Question: What type of chart is this?
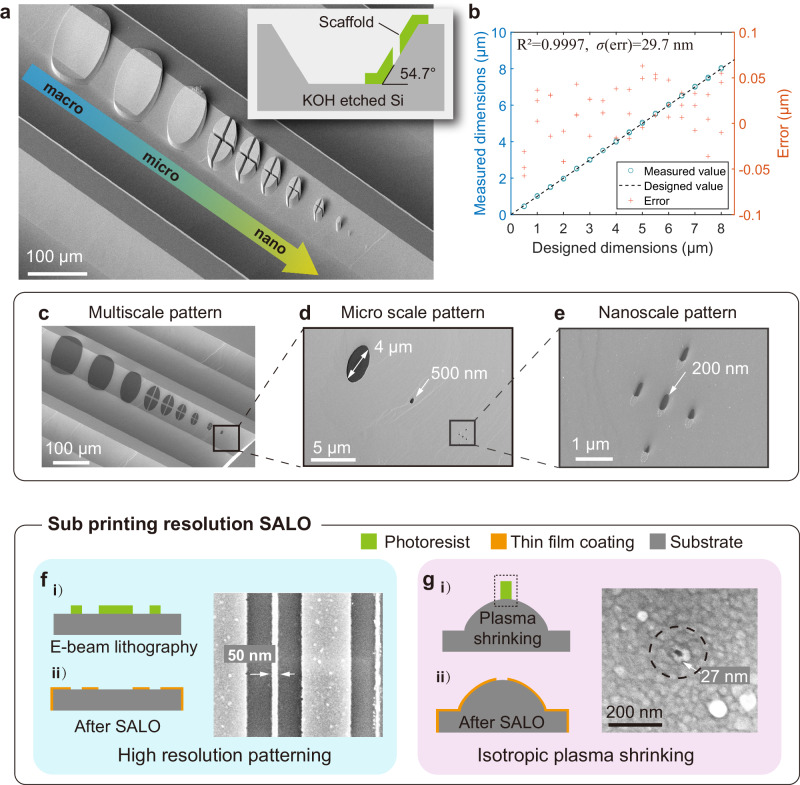
Answer: line